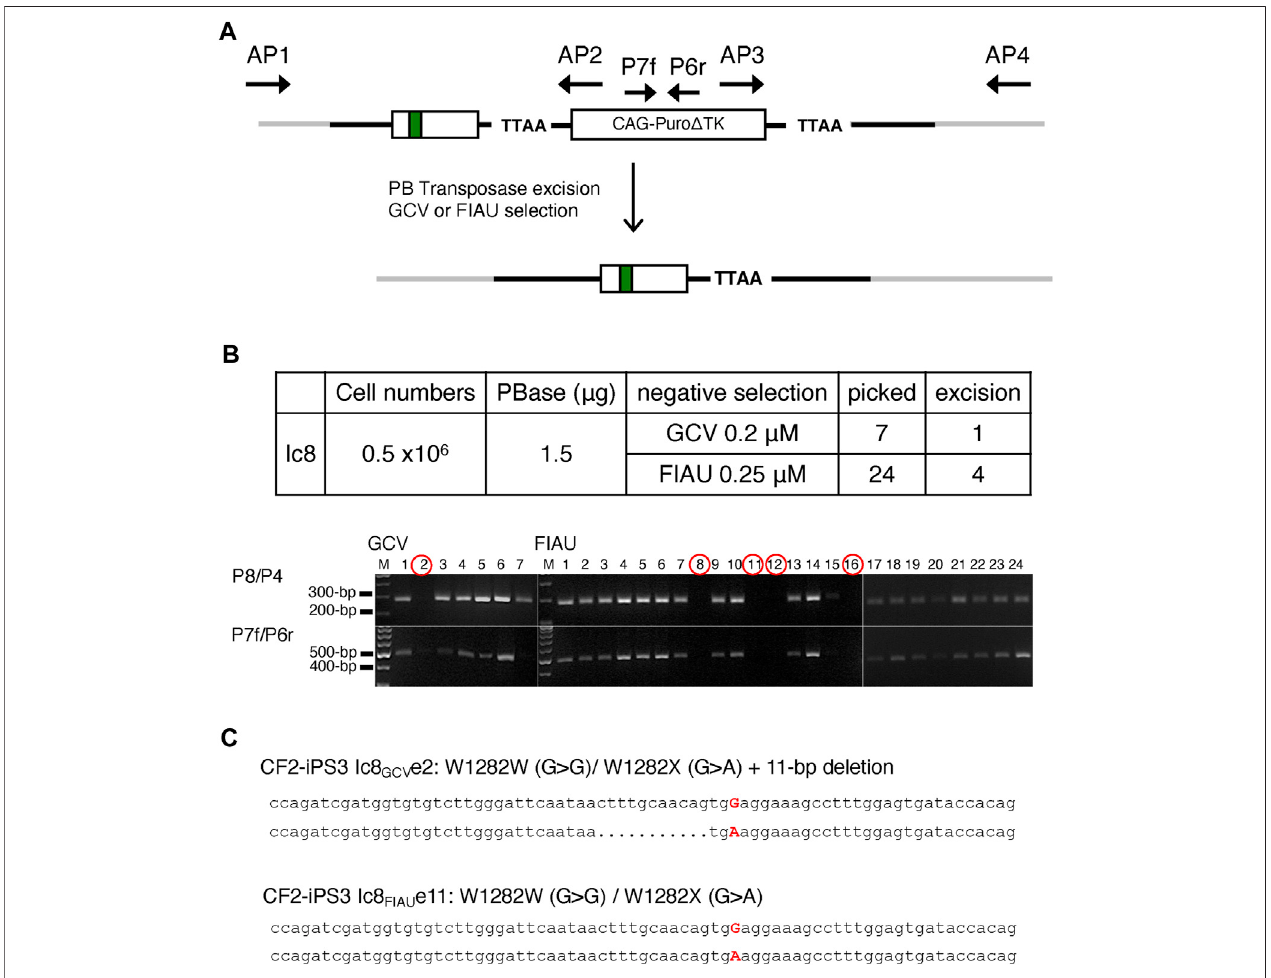
FIGURE 3 | PBase Removal of the Puro Δ TK Cassette from Vector Replacement Cell Lines. (A) Graphic illustration of the Puro Δ TK cassette excision. (B) Colonies survivingGCV orFIAUselectionexcisionwerecon fi rmed asPuro Δ TK cassette negative clones byPCRusingP8/P4 andP7f/P6r primerstogeneratethePCRresultsas shown in gel pictures. M; 100 bp DNA ladder plus. (C) Sequence of excised clones screened from PBase-transfected Ic8 clones selected with 0.2 μ M of GCV (Ic8GCVe2,topclone)orwithFIAU(Ic8FIAUe11,bottomclone).Adenine(A)andGuanine(G)capitalizedandhighlightedinredrepresenting W1282X mutation(G > A) and the correction (A > G), respectively. Dot represents deleted